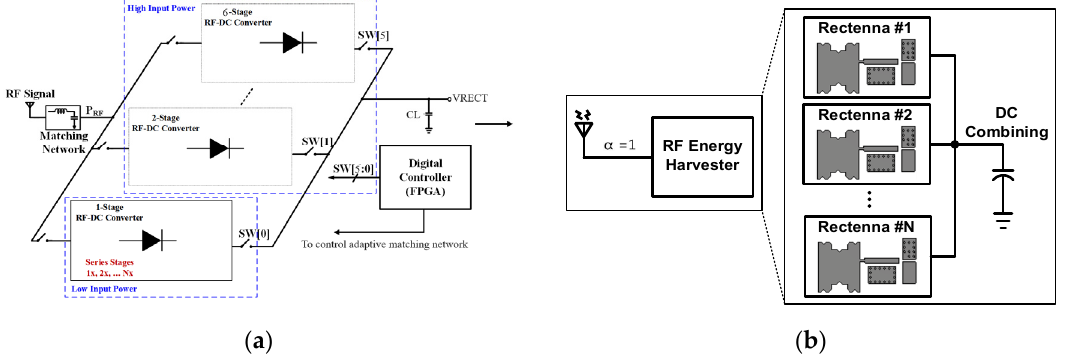
Figure 4. ( a ) The proposed rectenna structure and ( b ) Its parallel configuration. Reprint with permission [4775431338148]; 2020,